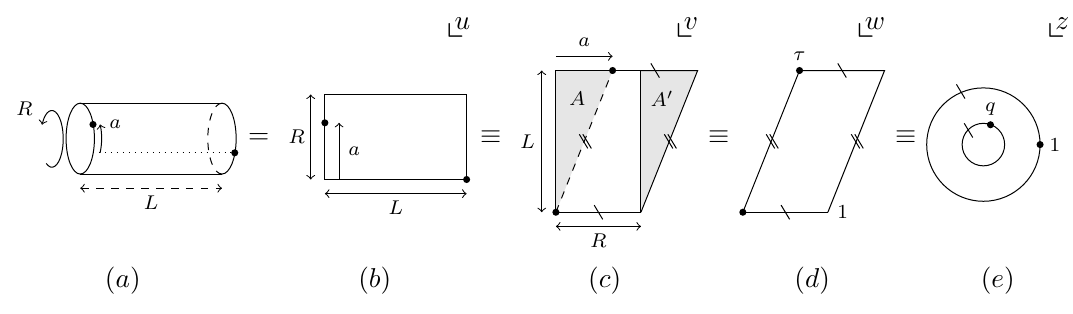
Figure 1. (a) The cylinder of length L , circumference R with a translation through a before the identification of the ends can be realised as a quotient of the plane (b) and (c), and is equivalent (after rescaling) to a torus (d) with modular parameter τ and an annulus (e) with coordinates w, u, v, z respectively. The solid points are identified in each